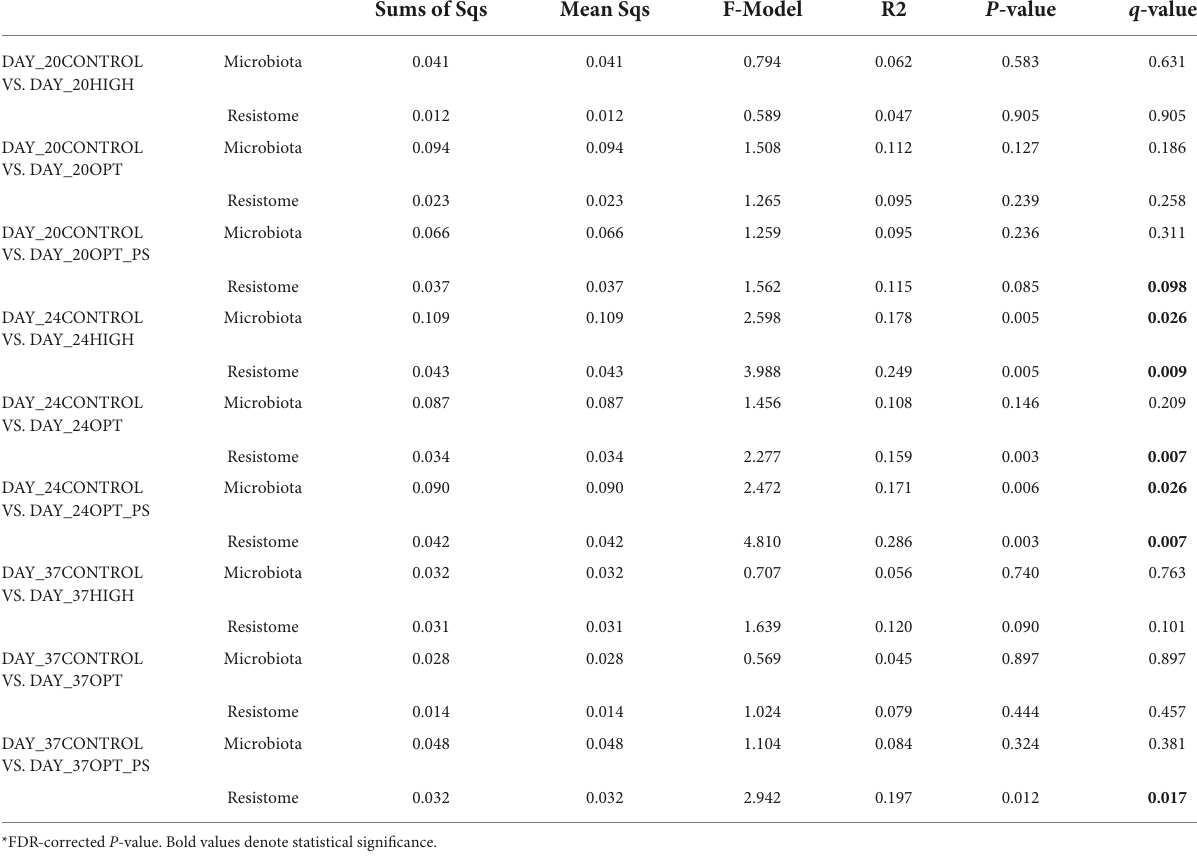
TABLE 2 Pairwise comparisons for permutational multivariate analysis of variance (PERMANOVA) using bray-cutis distance matrices. Sums of Sqs Mean Sqs